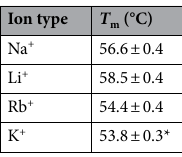
Table 1. Transition temperature ( T m ) values of HepB_FRET in presence of 140 mM ions. *Average of two parallel